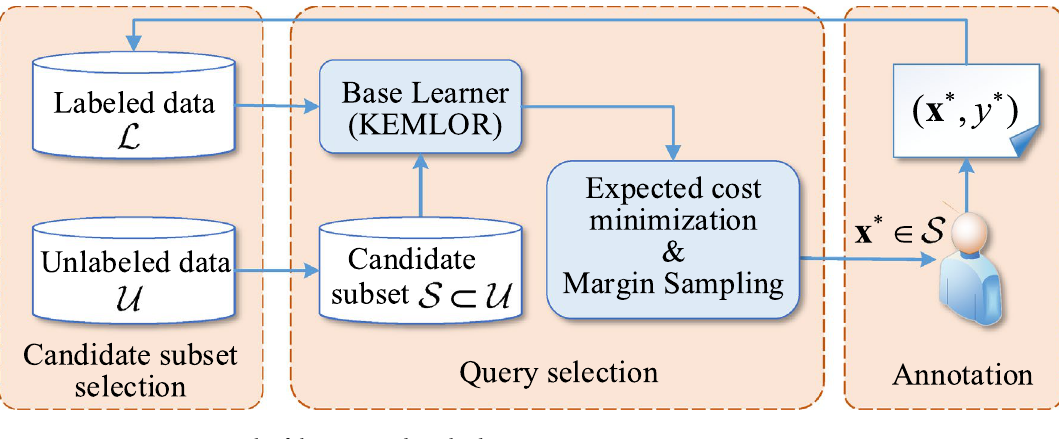
Figure 1. Framework of the proposed